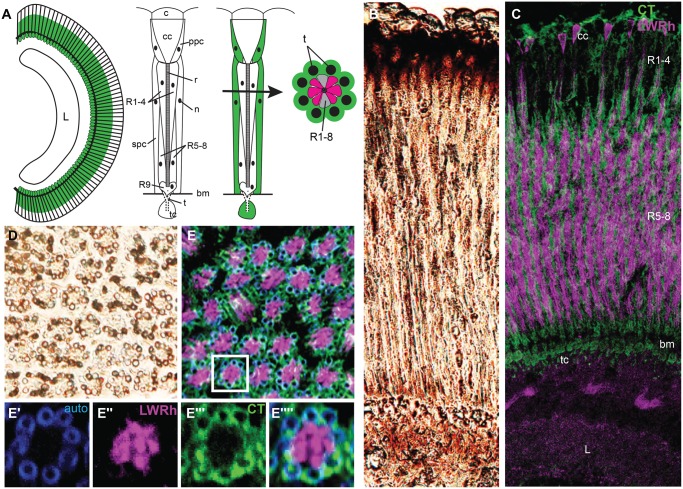

—Immunohistochemistry of Hme CTD31 in Heliconius melpomene eye and optic lobe. (
A) Drawing of a longitudinal view of a compound eye and lamina, and longitudinal and transverse sections of a single ommatidium. Green highlights where we find Hme CTD31 expression; L, lamina; c, cornea; cc, crystalline cone; ppc, primary pigment cells; r, rhabdom; R1-9 conventional Lepidoptera numbering of photoreceptor cells; n, cell nucleus; spc, secondary pigment cells; bm, basement membrane; t, trachea; and tc, tracheal cell. (B) Brightfield longitudinal section showing pigments in the H. melpomene retina. (C) Longitudinal section with Hme CTD31 and LW opsin staining; Hme CTD31 is in green and LW opsin is in magenta. (D) Brightfield image of a transverse section of a butterfly eye, pigment is seen in the structures surrounding the ommatidia. (E) Transverse view of a butterfly eye stained for LW and Hme CTD31. (E′) autofluorescence showing tracheoles surrounding an individual ommatidium. (E′′) LW opsin staining showing where the LW photoreceptor cells are. (E′′′) CTD31 staining showing where the CRAL-TRIO domain protein Hme CTD31 is expressed. (E′′′′) merged image of LWRh, CTD31, and autofluorescence.